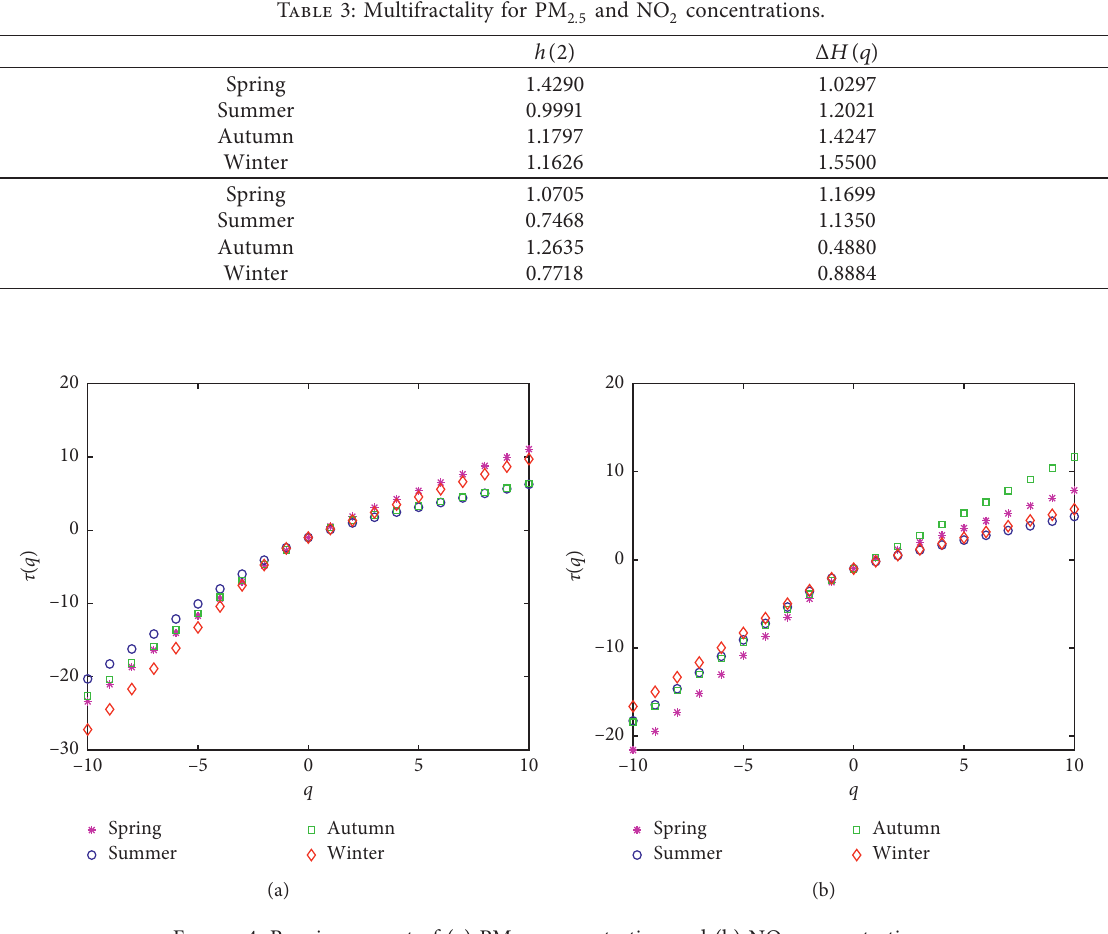
concentration and (b) NO 2 . 5